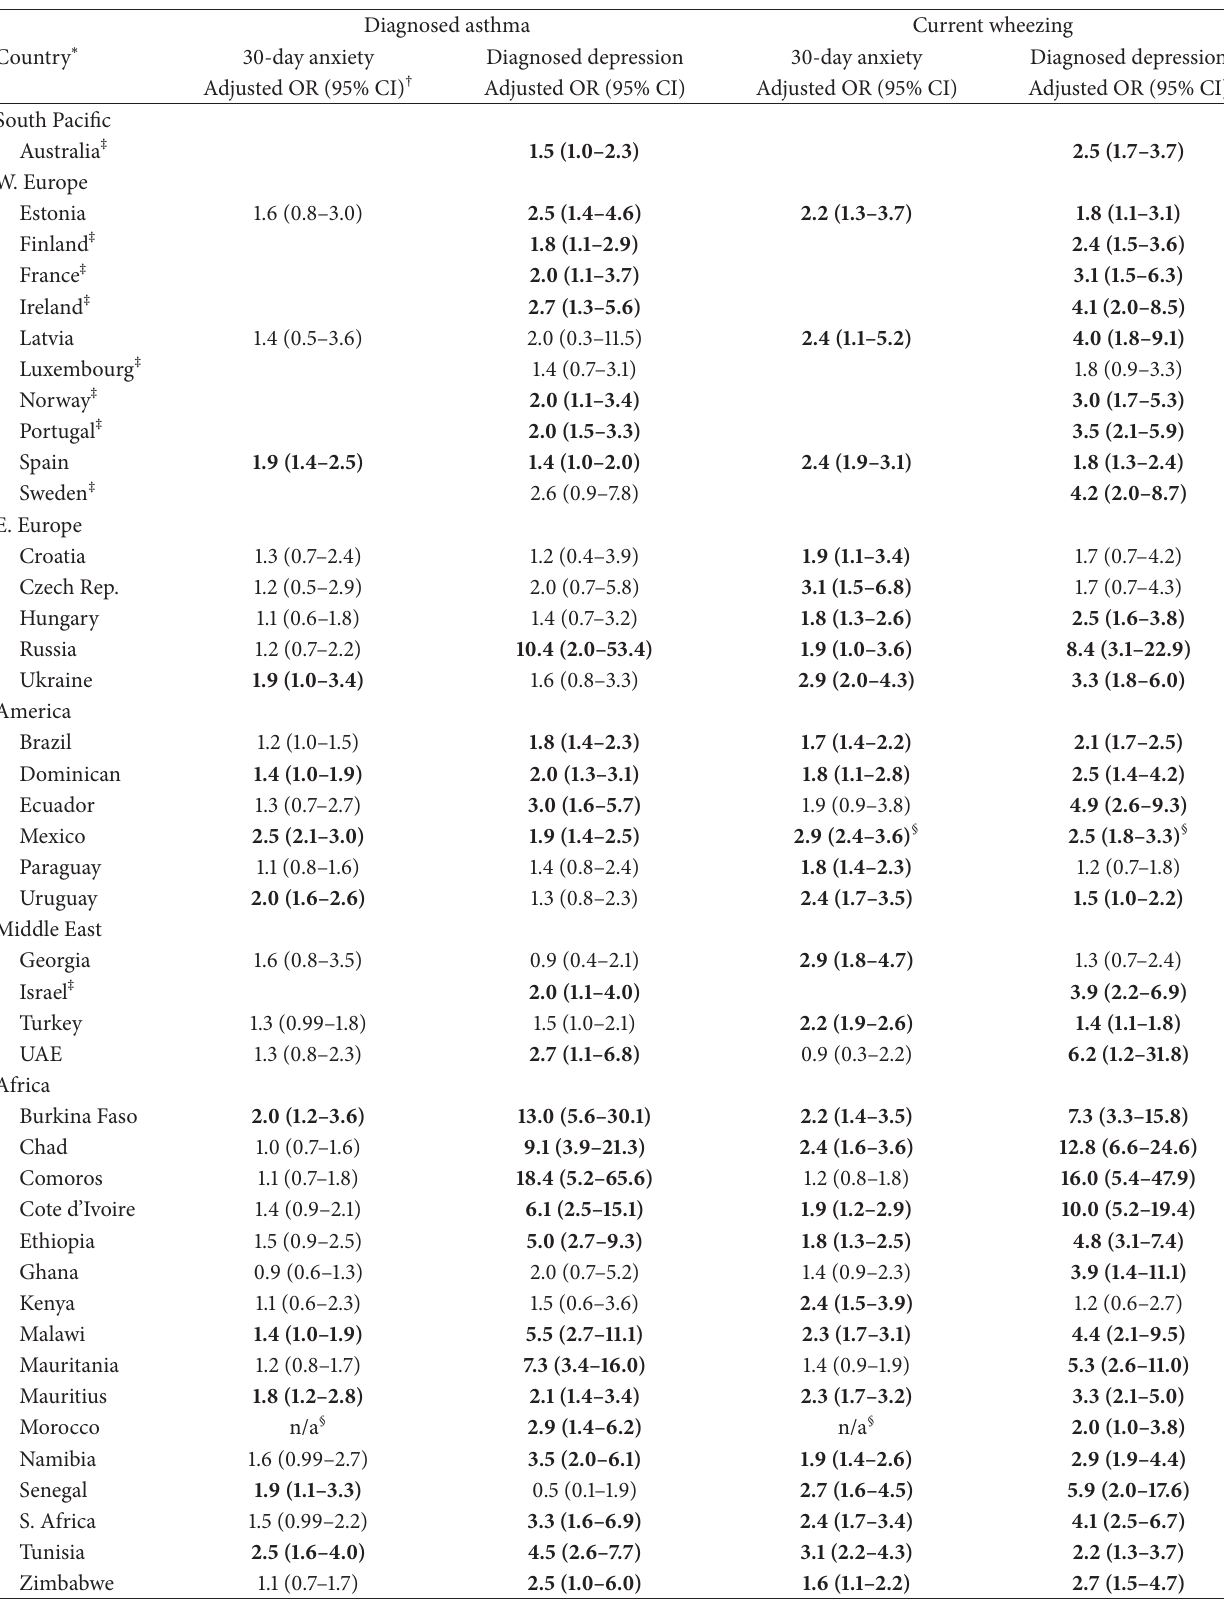
Table 1: Odds ratios and 95% confident intervals of diagnosed depression and 30-day anxiety on diagnosed asthma and current wheezing in adults by region and